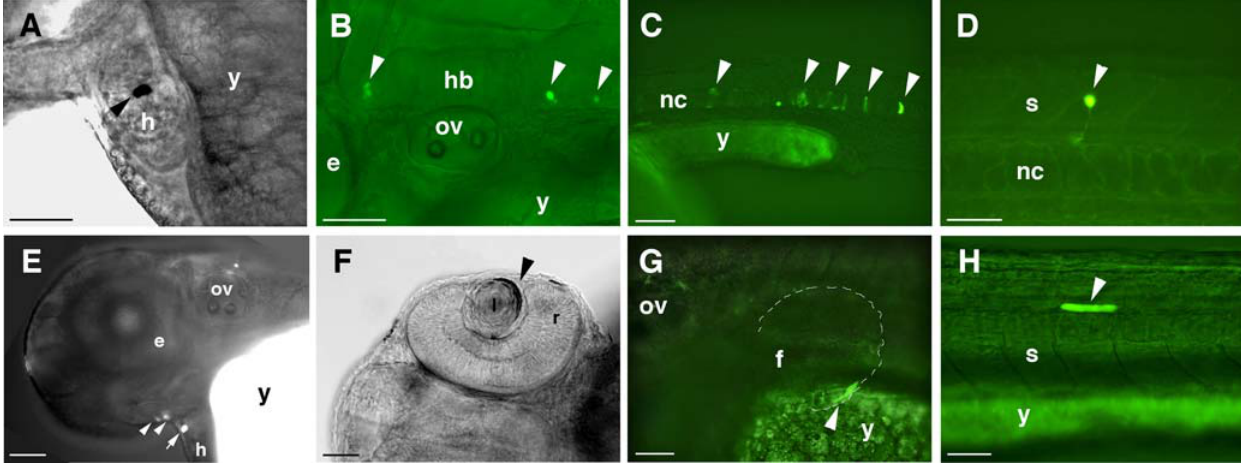
Figure 4. Tissue Type Specific Expression of GFP Reporter Gene in Zebrafish Embryos. Examples of GFP expression induced by CNEs 1, 9, 10, and 11 are shown in fixed tissues after wholemount anti-GFP immunostaining (bright field views A and F) or in live embryos by combined bright field and GFP fluorescence microscopy analyses (B, C, D, E, G and H). Arrowheads indicate GFP expressing cells. Embryos C and D are , 26–33 hpf, while embryos A, B, E, F, G, and H are 48–54 hpf. Lateral views, anterior to the left and dorsal to the top except for F where the dorsal view is shown. GFP positive cells were found in the following: (A) CNE1, heart chamber (B) CNE1, hindbrain neurons (C) CNE9, notochord (D) CNE9, spinal cord neuron (E) CNE10, lower jaw primordia and pericardial regions (F) CNE10, lens epithelial cell layer (G) CNE11, pectoral fin (H) CNE11, muscle. (e) Eye; (f) fin; (h) heart; (hb) hindbrain; (I) lens; (nc) notochord; (ov) otic vesicle; (r) retina; (s) spinal cord; (y) yolk.